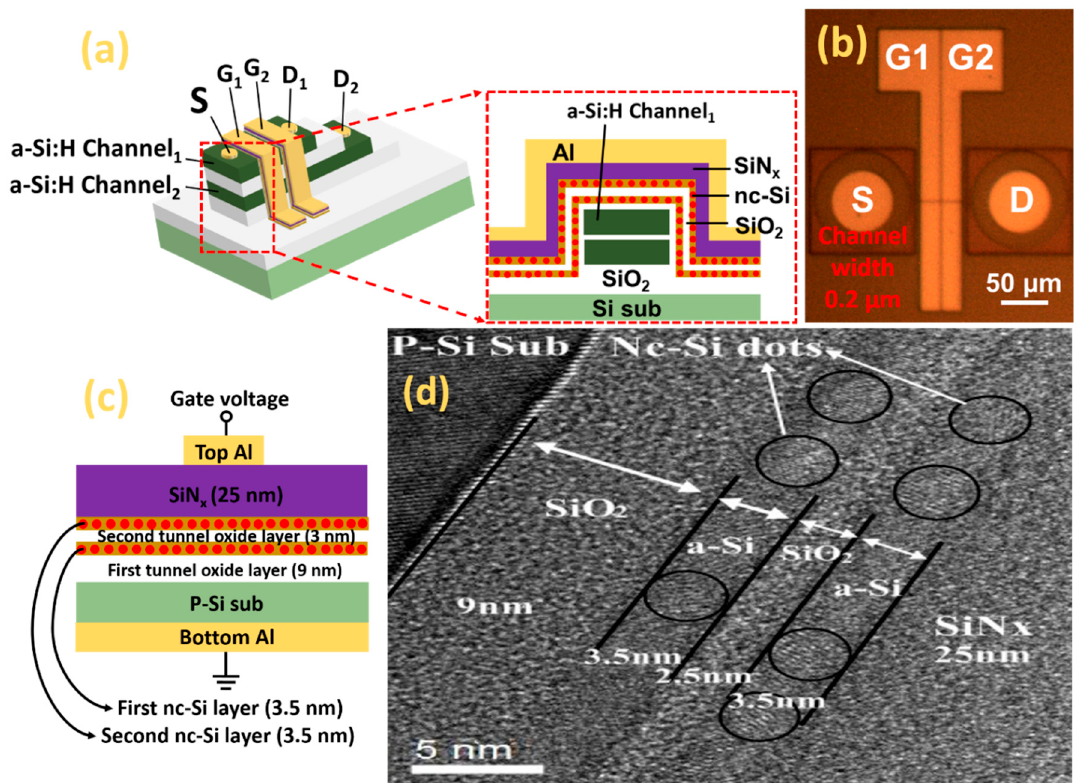
Figure 1. ( a ) Schematic diagram of 3D flash memory based on double-layer a-Si:H channels with a double-layered nc-Si dots floating gate structure. ( b ) The top-view morphology of the 3D flash memory with channel width of 0.2 µm. ( c ) Schematic diagram of MOS device with double-layer nc-Si floating gate for C-V measurement. ( d ) HRTEM photo of the SiN x /nc-Si/SiO 2 /nc-Si/SiO 2 double-layered MOS structure. The black circles represent nc-Si quantum dots.